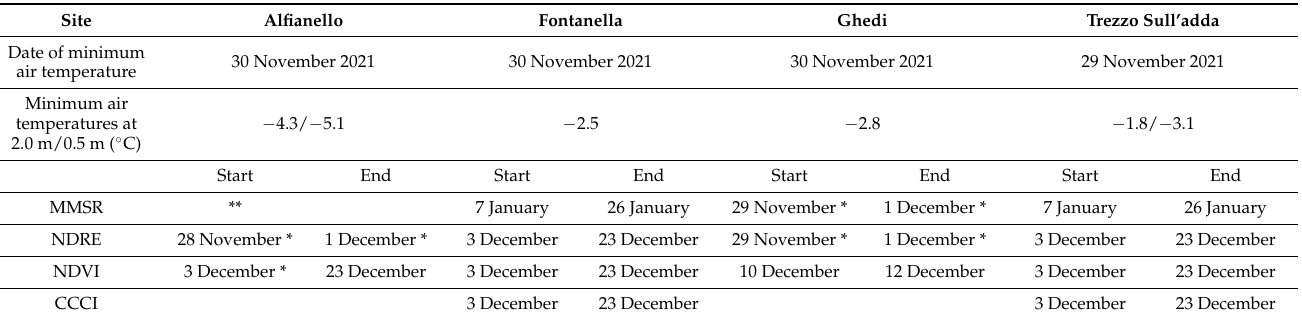
Table 3. Start and end dates of the frost events for each VI × site combination using the ‘peak-based method’. EVI did not identify frost damage.